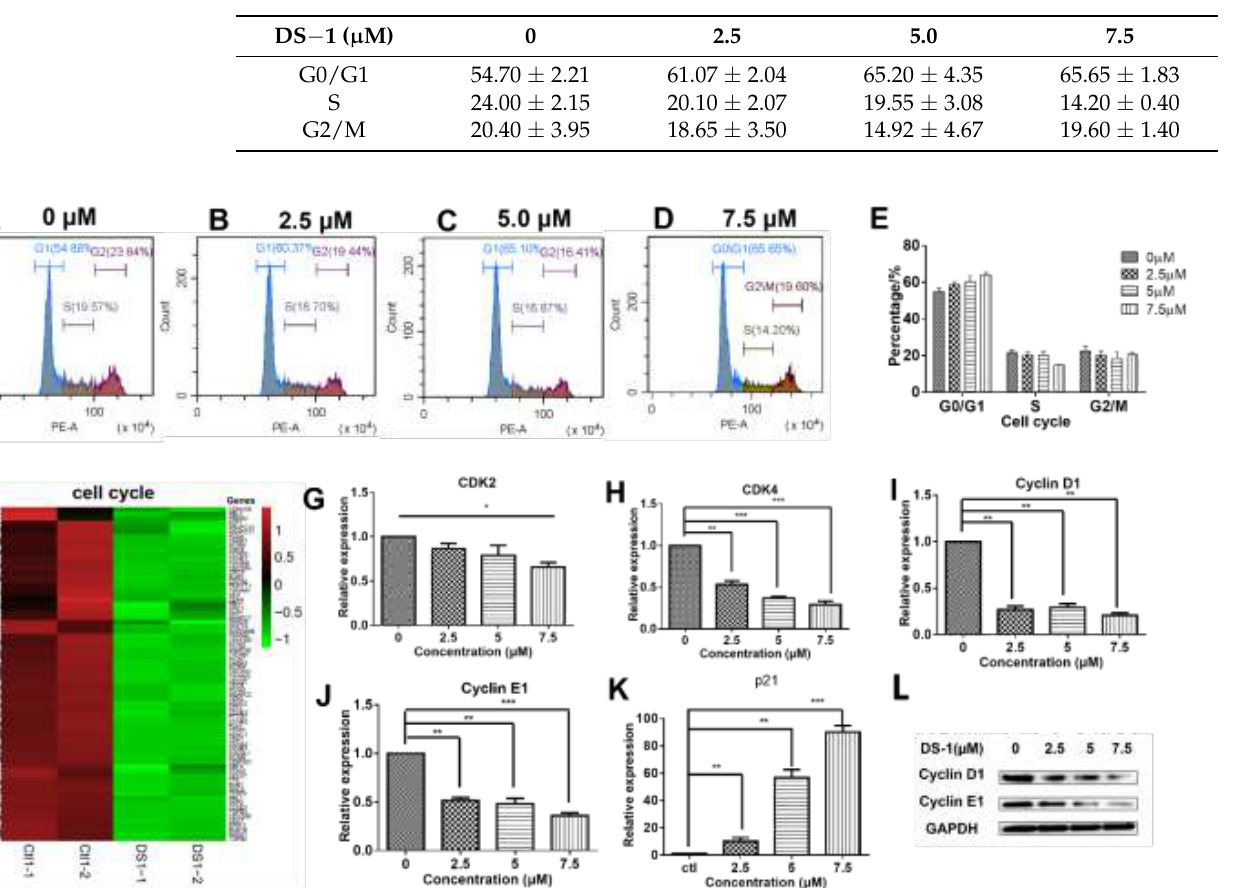
Table 2. Cell cycle distribution of U − 2 OS cells treated with/without DS − 1.